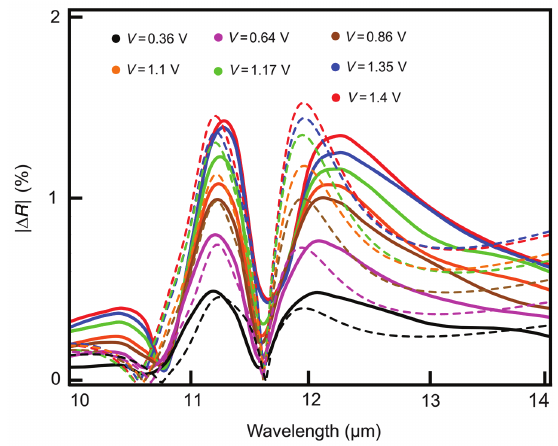
Figure 4: SPPD reflectivity modulation under external voltage bias. The absolute change in reflectivity is experimentally obtained under various forward bias voltages (solid lines) and compared with the self-consistent electro-optic simulations (dashed